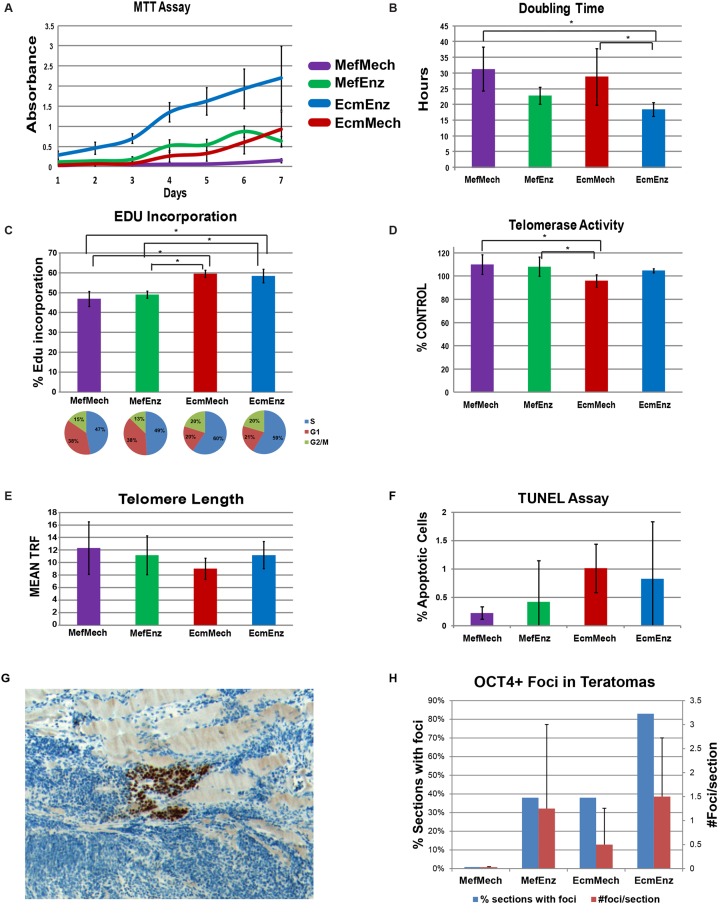
Phenotypic assays.Horizontal brackets indicate significant differences between the specified conditions, as calculated using ANOVA (p-value<0.05). A. The MTT assay measures cell proliferation, with absorbance being correlated with cell growth. B. Doubling time was calculated from cell counts taken over 3 days (average of 3 replicates per condition). C. The EdU incorporation was determined via FACS, and reveals the cell cycle distribution. The graph shows the percent of cells in S phase. D. Relative telomerase activity is shown. E. Average number of telomere repeat fragments (TRF, average of 3 replicates) for each condition. F. Percent of apoptotic cells, determined using TUNEL-FACS. G. Example of an OCT4-positive focus in a teratoma section. H. Bar graph showing, for each culture condition, the percent of teratoma sections containing at least one OCT4-positive focus, and the average number of foci per section. The error bar indicates the standard deviation of counts from 6 (EcmEnz), 7 (MefMech), or 8 (MefEnz and EcmMech) sections. Raw counts can be found in S4 Table).